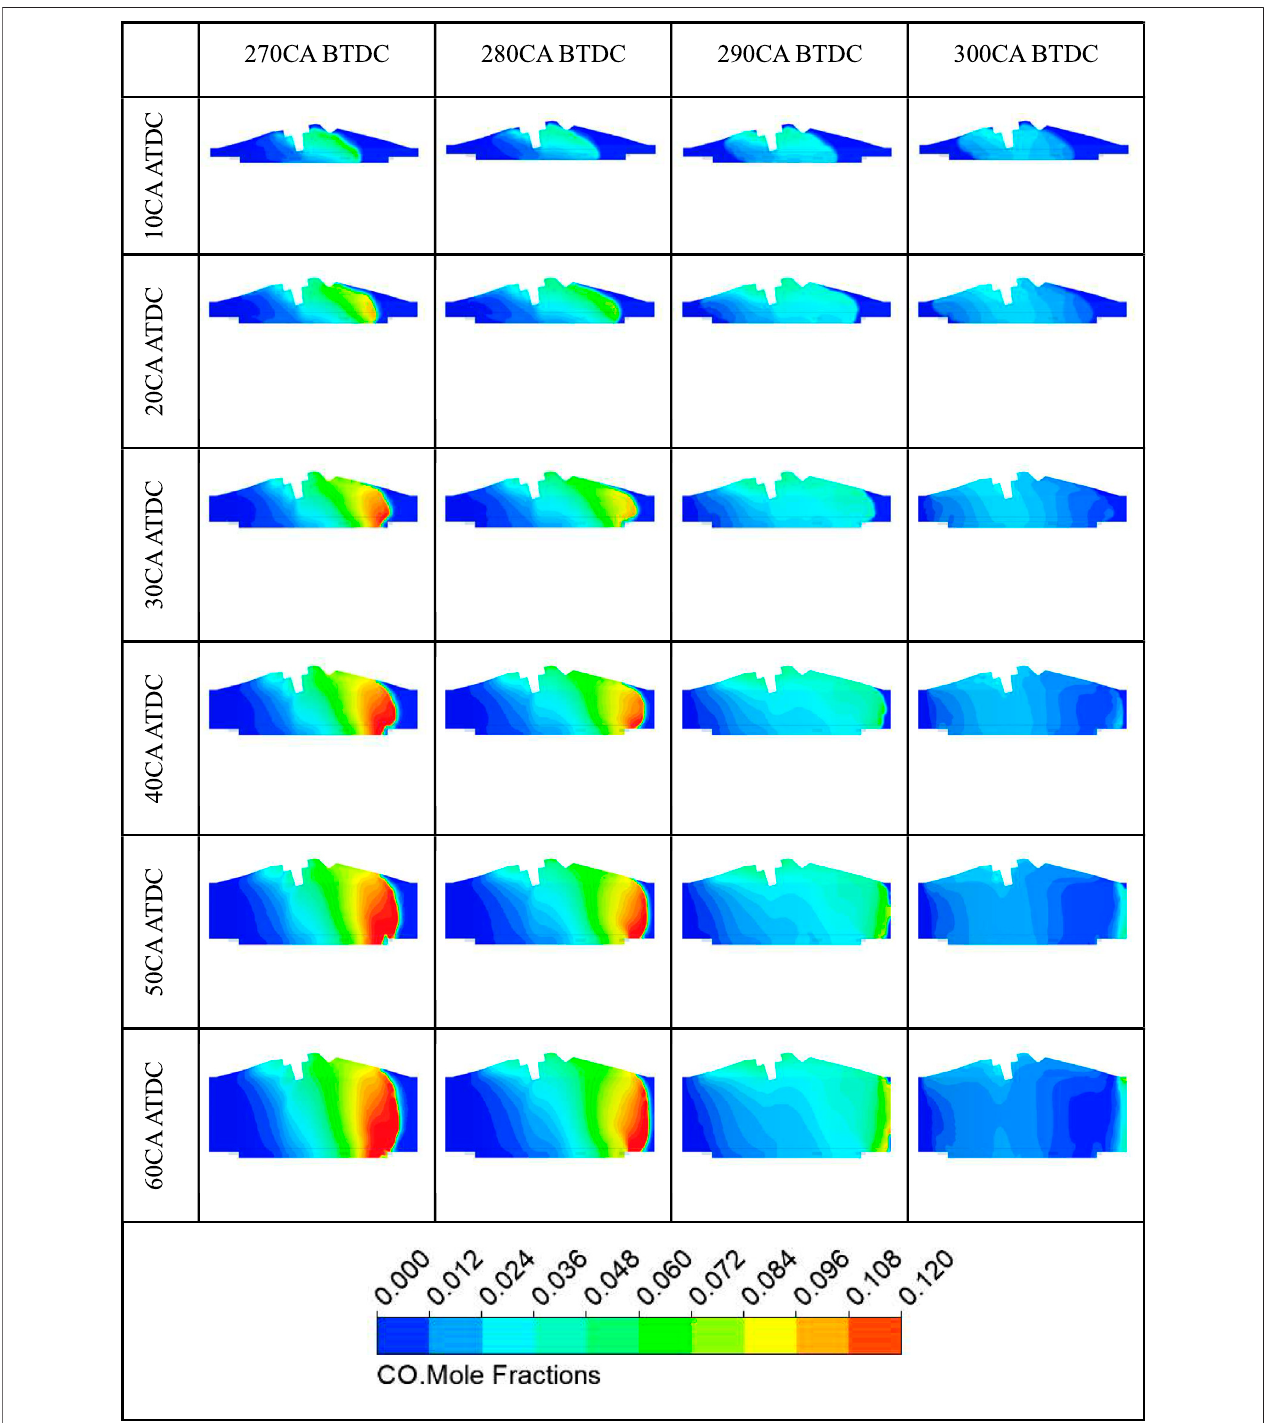
FIGURE 18 | Effect of injection timing on CO generation at several CAD in combustion duration.